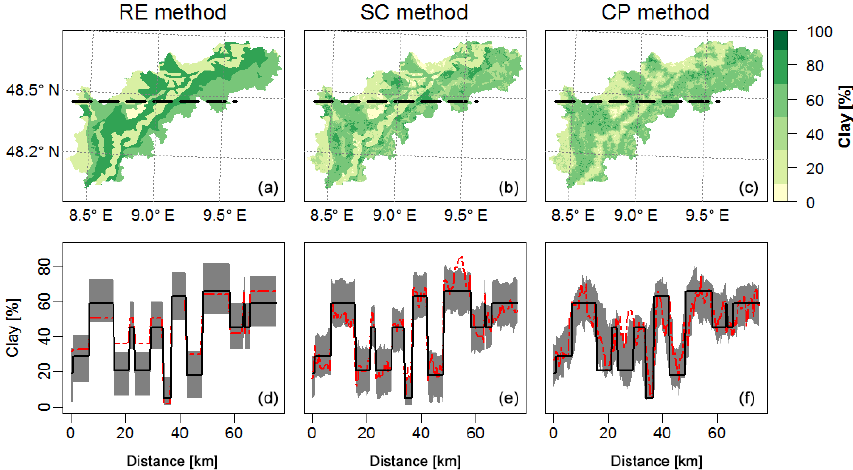
Figure 4. Soil realizations obtained for the percentage of clay based on the random error method (RE, left column), spatially correlated method (SC, middle) and conditional points method (CP, right column). The top row shows one realization for each method and the transect (dashed black line). The bottom row depicts the spread of the 100 realizations by using the 5th and 95th percentile for the selected transect (grey area). The red line depicts one realization, whereas the black line shows the percentage of clay by the original soil map.